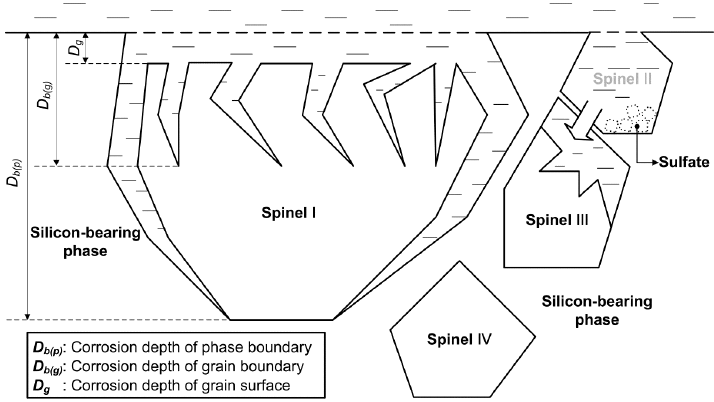
Figure 3. Leaching mechanism of chromite with sulfuric acid [57].